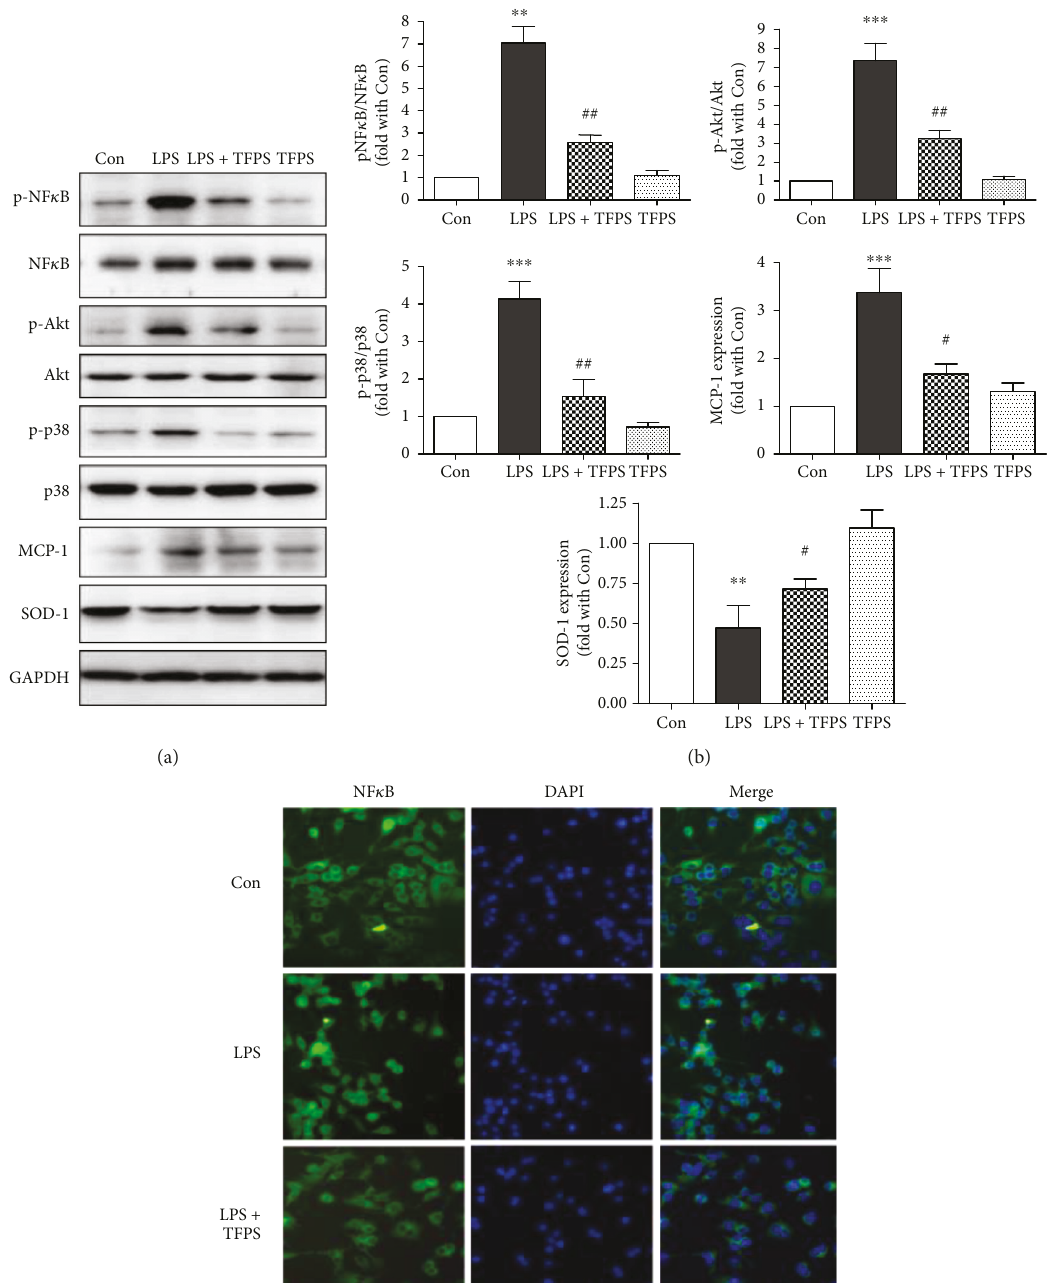
Figure 6: The signaling pathways that TFPS attenuates during LPS-induced RAW264.7 cell injury. (a, b) The phosphorylated-Akt, Akt, phosphorylated-p38MAPK, p38MAPK, phosphorylated-NF κ B, NF κ B, MCP-1, SOD-1, and GAPDH protein expression levels in